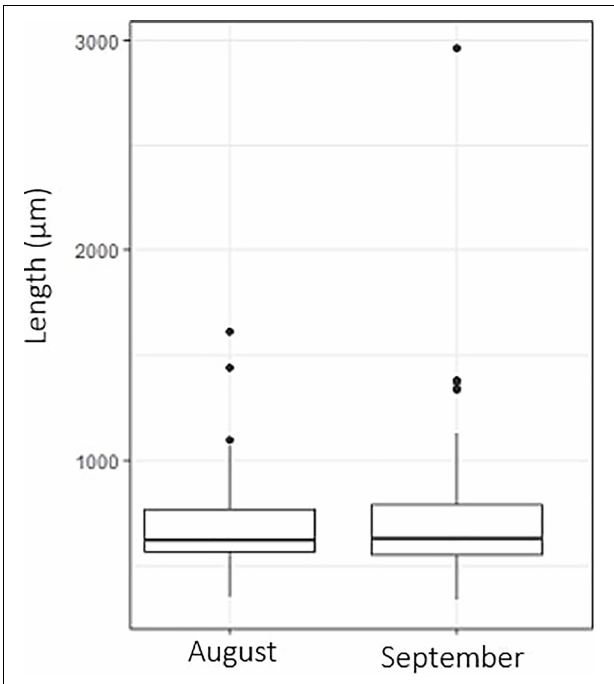
FIGURE 5 | Limacina helicina size range of individuals collected during August ( n = 40) and September ( n = 98) sampling dates. 2014 and 2017 samples are